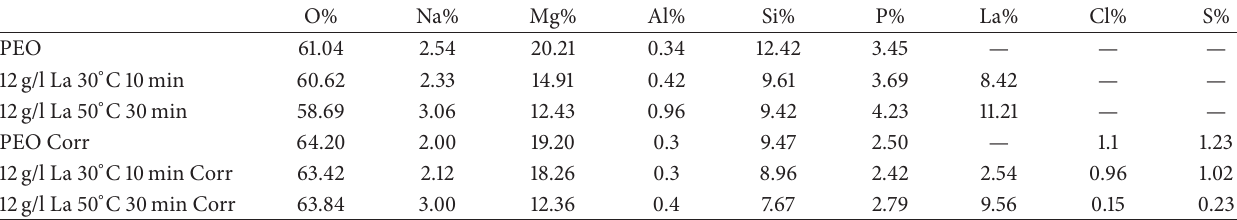
Table 5: Quantitative results (at %) of EDS analysis of the samples before and after 7 days of immersion.